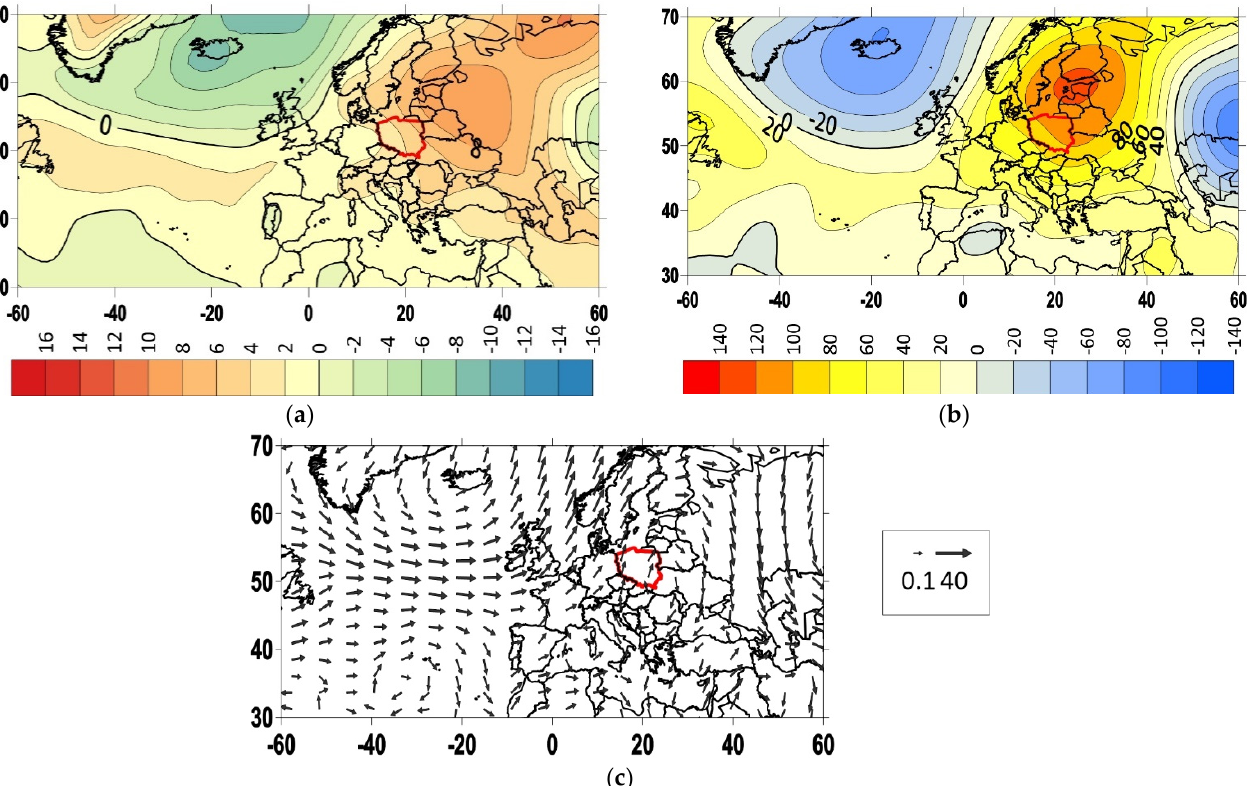
Figure 10. Average fields for the 2019 heat wave: ( a ) anomalies of SLP; ( b ) anomalies of HGT700 mb; ( c ) wind at 700 hPa level. The red line marks the borders of Poland.